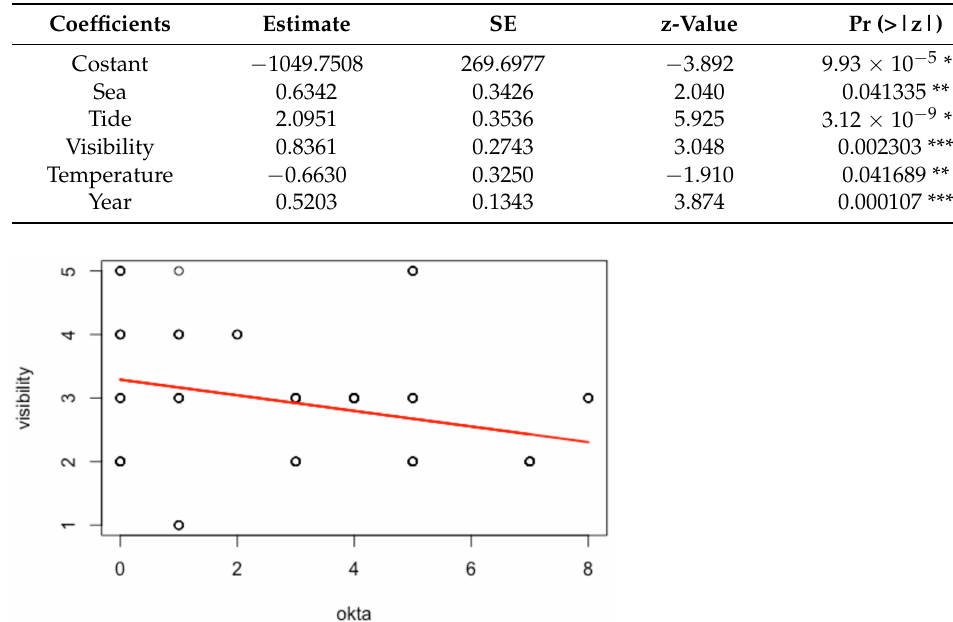
Figure 2. Scatter plot by regressing ‘okta’ (independent variable) on ‘visibility’ (dependent variable). The estimation output is negative and significant, displaying a consistent relationship between the variables. The scatter plot shows a large component of outliers affecting the output due to omitted variables and unobserved heterogeneity (endogeneity issues) dealt with the logistic function. The significance level used in the analysis is α = 5% (as default).